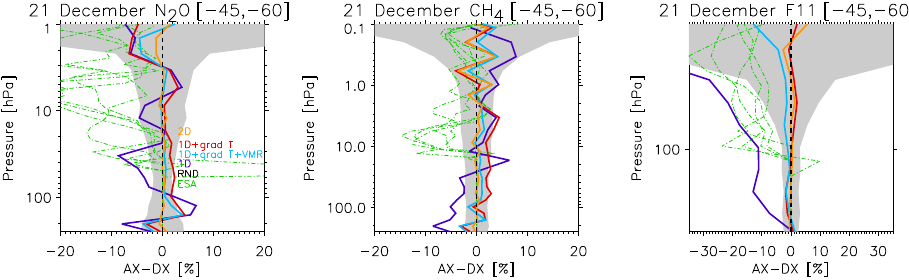
Figure 4. AX–DX differences on 21 December 2011 in the 45–60 ◦ S latitude band for N 2 O, CH 4 and CFC-11. The colour code is the same as in Fig. 2.